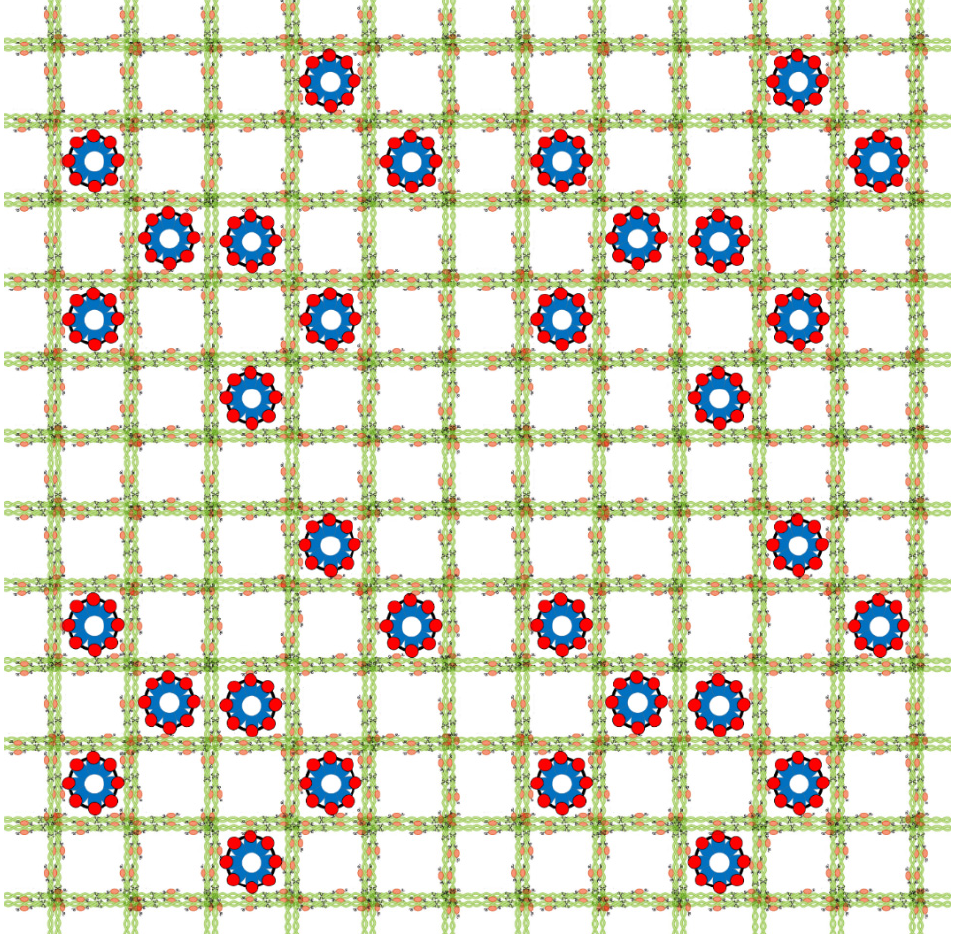
Figure 1. Schematic representation of nuclear lamina structure (as visualized in EM micrographs by Aebi and colleagues [17]). Lamin A/C and Lamin B oligomerize via head-to-tail interactions to form intermediate filaments. These filaments then organize into higher order filaments (green and orange cables) forming a lattice-like pattern under the nuclear envelope that helps to stabilize protein complexes, such as nuclear pore complexes (blue and red structures) and allow for the transport of proteins.